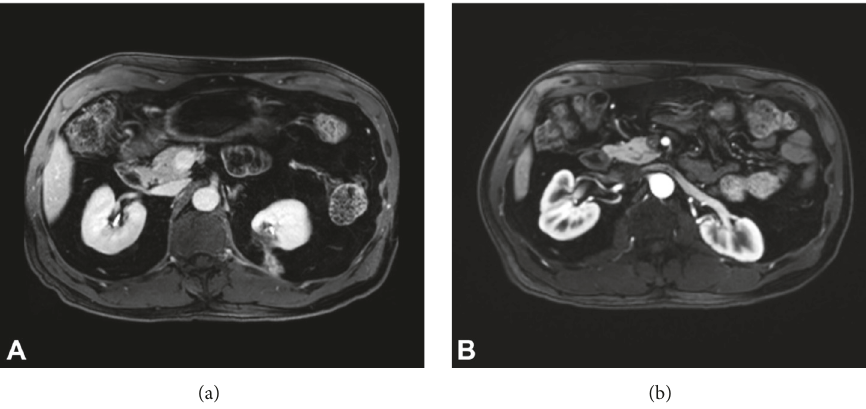
Figure 2: Patient imaging following cryoablation. (a) Contrasted MRI 2 years following cryoablation of left renal mass demonstrating new lesion development described as an ill-defined 2-centimeter focus of soft tissue highly suspicious for disease recurrence. The lesion appears to follow the cryoablation tract path. (b) Contrasted MRI 2-year status-post-partial nephrectomy of left renal lesion with full excision of perinephric fat displaying stable changes of bilateral partial nephrectomy without evidence of local